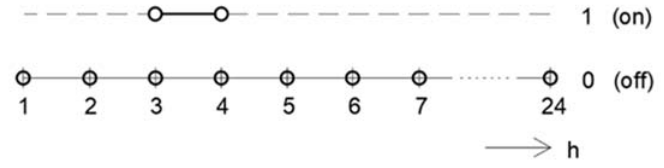
Figure 5. Construction of RES start ‐ up in time.